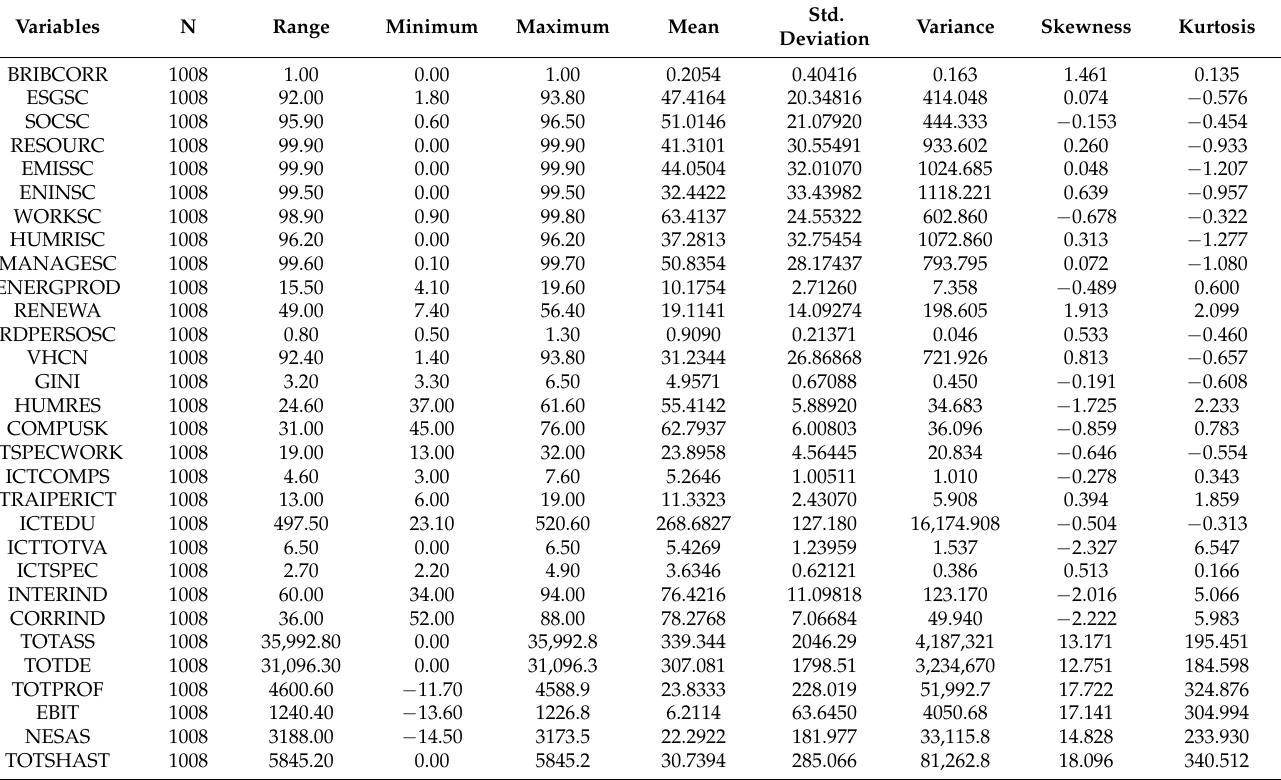
Table 4. Descriptive statistics of panel data